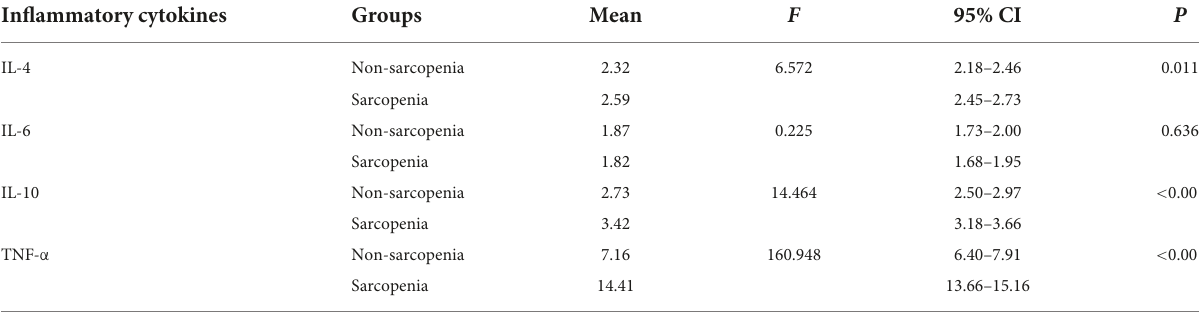
TABLE 3 Analysis of inflammatory factors after adjusting for sex, age, hypertension, blood lipid concentration, and